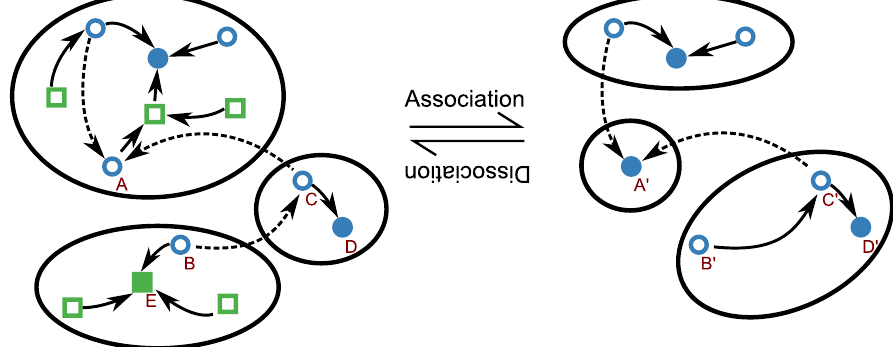
Figure 3. Energy landscapes of the coarse-grained RNA–ligand kinetic approach. There is a simple correspondence between the energy landscapes of monomers ( left ) and dimers ( right ): all secondary structures are states of the monomer landscape, whether they are binding-competent (circles) or not (squares); the dimer landscape is only composed of the structures with binding pocket. State transitions within each landscape are indicated by arrows; the individual associations and dissociations of the ligand (i.e., transitions between corresponding binding-competent states of the two landscapes), are not drawn here. To reduce the problem size (i.e., for coarse graining), the states are combined into macro-states defined by basins of attraction to local minima (filled squares and circles). Each secondary structure x is attracted to the local minimum that is the target of the ’gradient walk’ starting from x , which corresponds to the energetically steepest descending walk. Such walks follow the solid arrows. The dashed arrows represent transitions to energetically better structures that are not maximally steep. Due to the construction of basins, there is generally no one-to-one correspondence between the macro-states of both landscapes. For example, while the monomer state A has a gradient transition, the corresponding dimer state A (cid:48) has no gradient transition. Thus, A (cid:48) constitutes a dimer macro-state without corresponding monomer macro-state. Similarly, there are macro-states of the monomer landscape without corresponding dimer macro-state: since the local minimum E is not binding competent, there is no corresponding dimer; while there is a gradient transition from B to E , B (cid:48) is attracted to D (via gradient transition to C (cid:48)